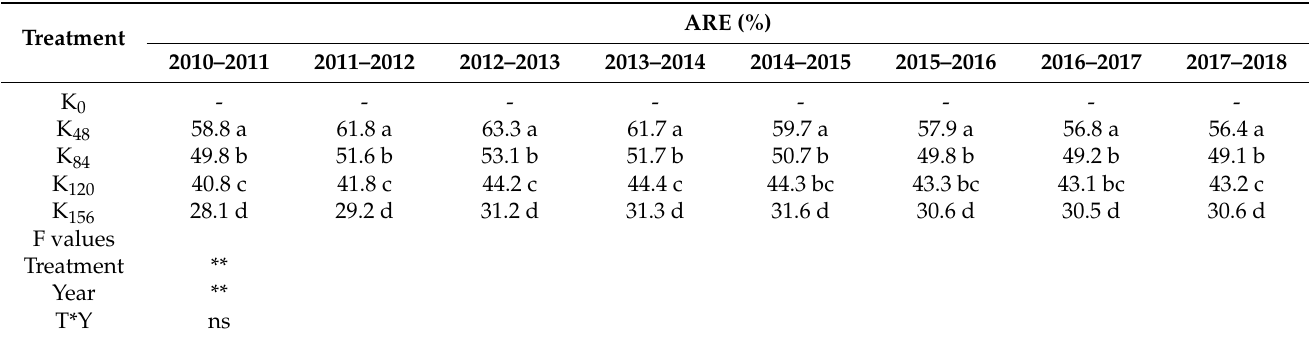
Table 3. Effects of different K fertilization rates on accumulative recovery efficiency (ARE) in the maize–wheat rotation